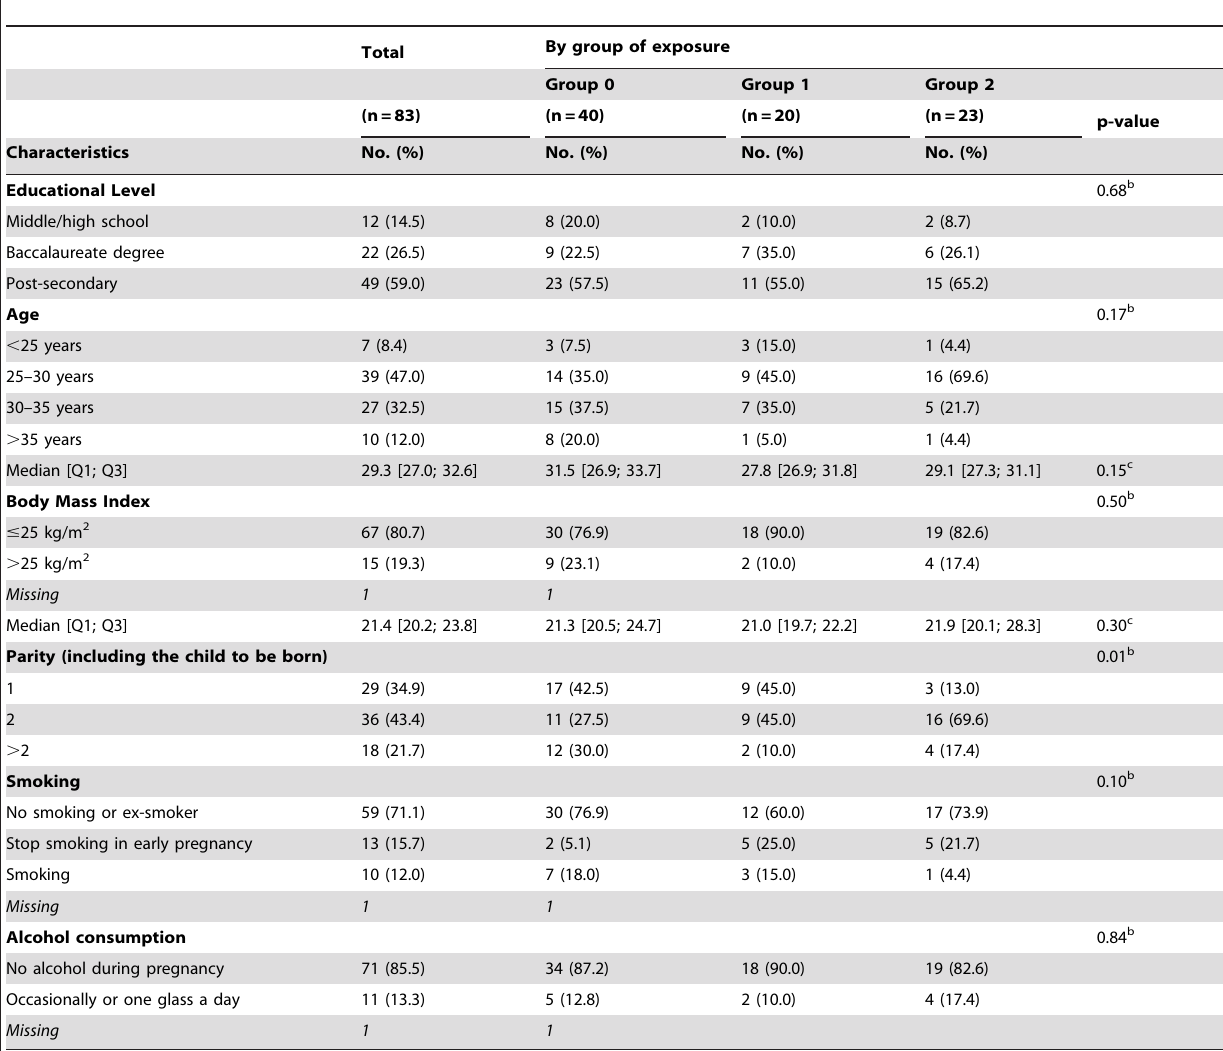
Table 1. Characteristics of the 83 pregnant women included in the metabolomic study by group of exposure a